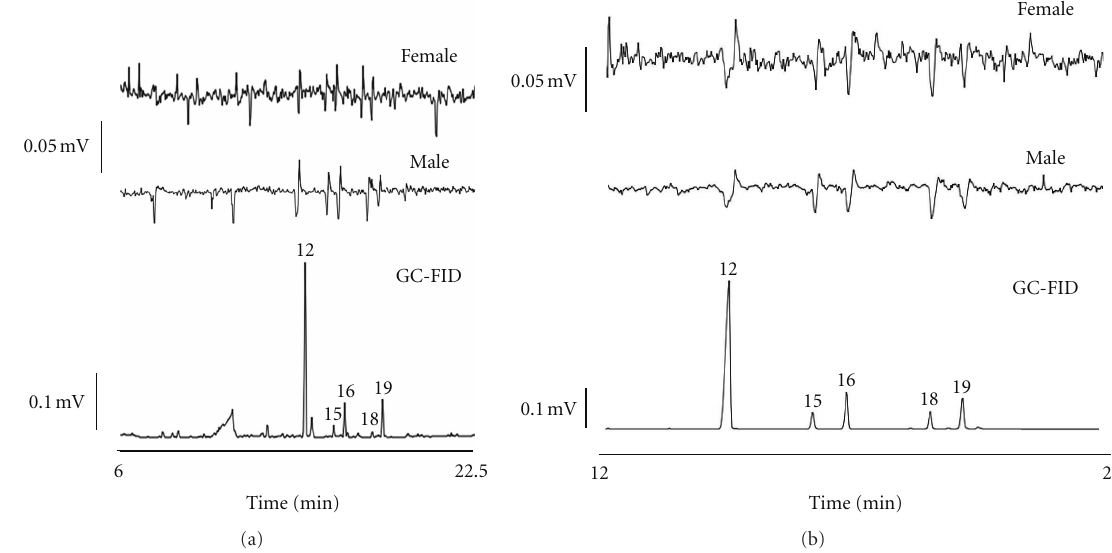
Figure 2: (a) A typical response to crude extracts of female aerations of antenna of Neomegalotomus parvus female and male in GC- EAG analyses. (b) A typical response to a synthetic mixture of compounds found in N. parvus aerations and scent glands of antenna of N. parvus female and male in GC-EAG analyses. (12) hexyl butanoate, (15) 4-methylhexyl-butanoate, (16) hexyl pentanoate, (18) 4- methylhexyl-pentanoate, and (19) hexyl hexanoate. In (b) the synthetic mixture tested was (12) hexyl butanoate (0.05mg/mL), (15) 4- S - methylhexyl-butanoate (0.005 mg/mL), (16) hexyl pentanoate (0.0075 mg/mL), (18) 4- S -methylhexyl-pentanoate (0.002mg/mL), and (19) hexyl hexanoate (0.0075